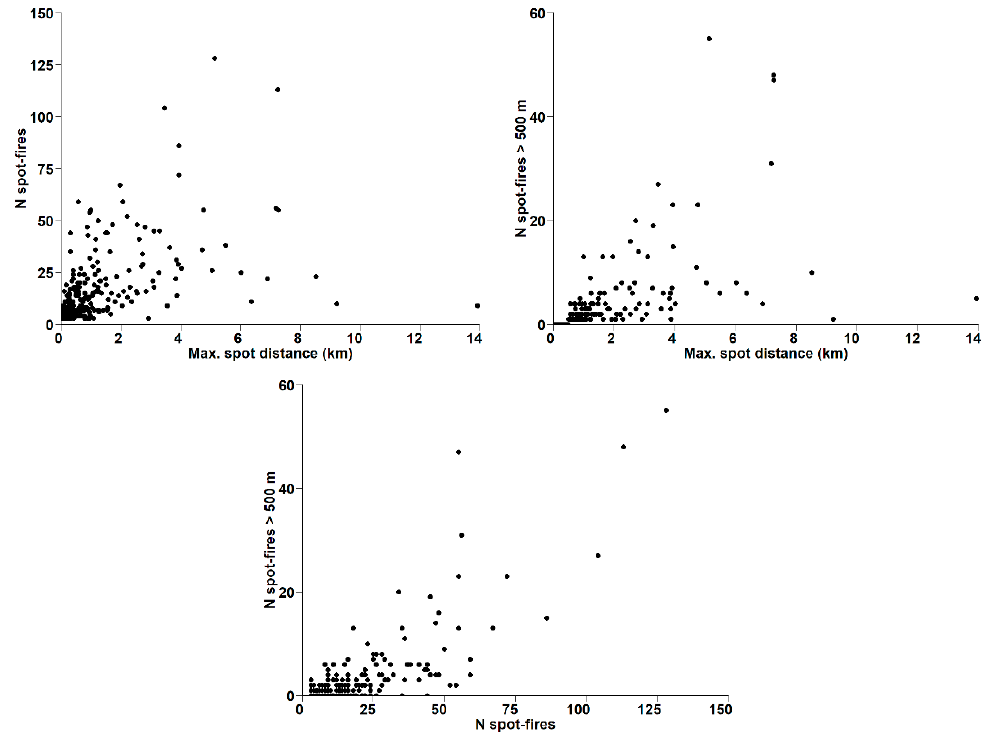
Figure 6. Scatterplots depicting pairwise relationships between the three spotting measures.